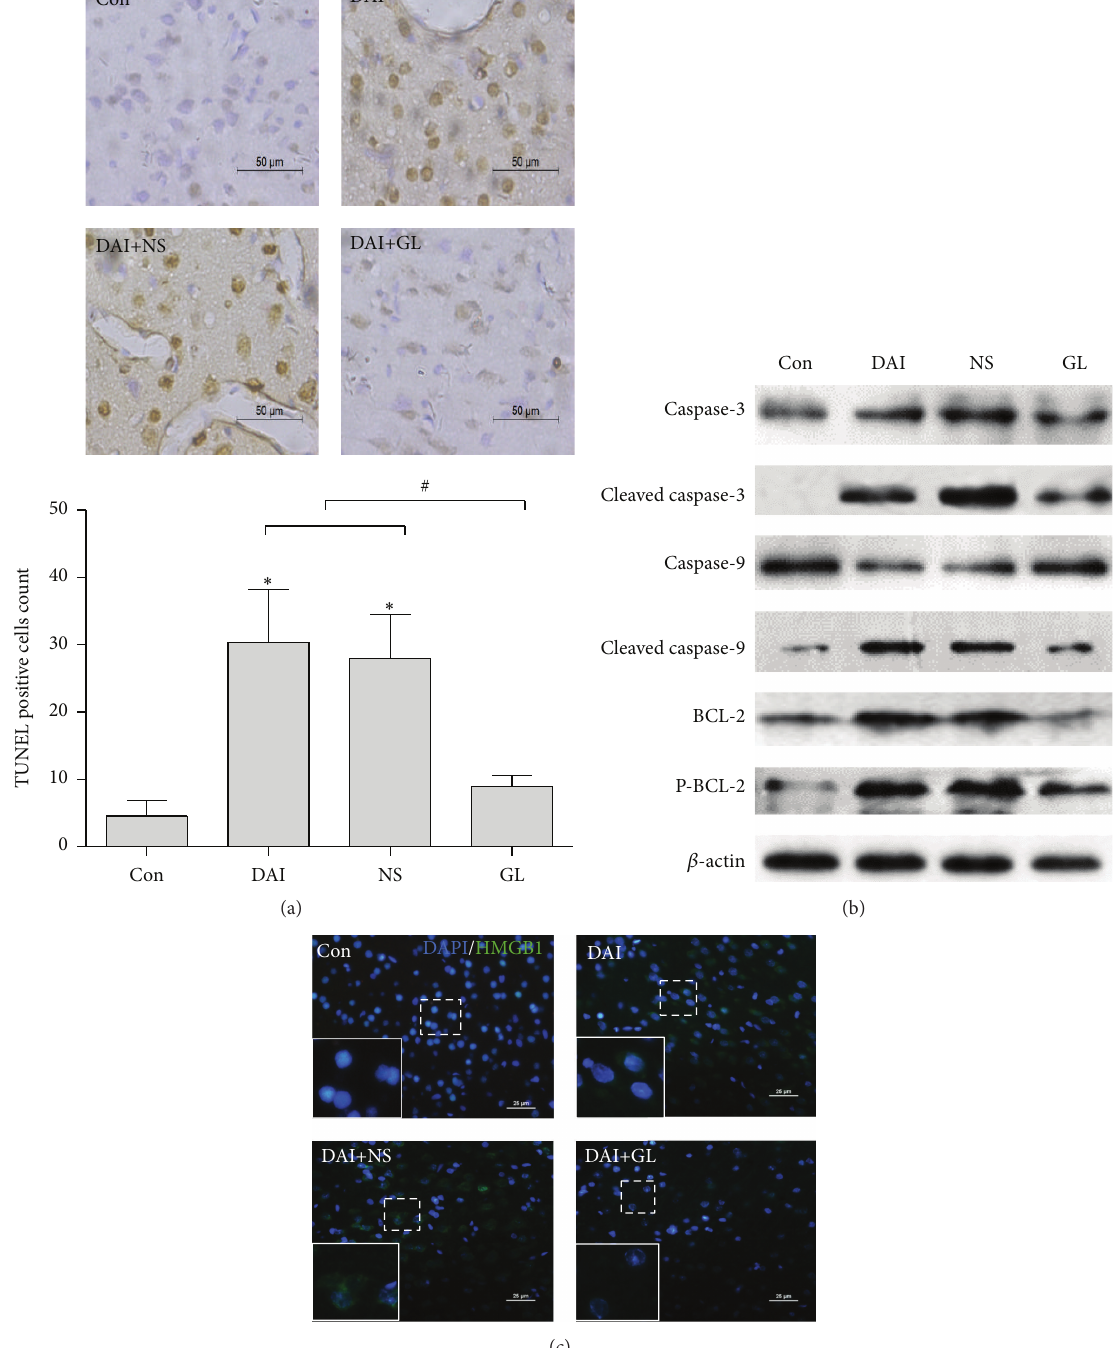
Figure 3: GL pretreatment reduced neuronal apoptosis by inhibiting the expression and cytosolic release of HMGB1 at 24 h after DAI. GL was administrated 30min before the induction of DAI at a dose of 10mg/kg, significantly reducing neuronal apoptosis compared with DAI + NS group (a). Western blot showed that the cleavage of caspases 3 and 9 and the phosphorylation of BCL-2 were suppressed by GL pretreatment compared with DAI + NS group (b). Immunofluorescence showed that HMGB1 was mainly present in the nucleus of neuronal cells, and no clear expression was found in the cytosol of the control rat brains. At 24 h after DAI, the cytosolic HMGB1 increased, and the nuclear HMGB1 showed a simultaneous slight decrease (data not shown). After GL pretreatment, the cytosolic expression of HMGB1 was clearly suppressed (c). ∗ 𝑝 < 0.05 compared with control group; # 𝑝 < 0.05 compared with DAI + saline